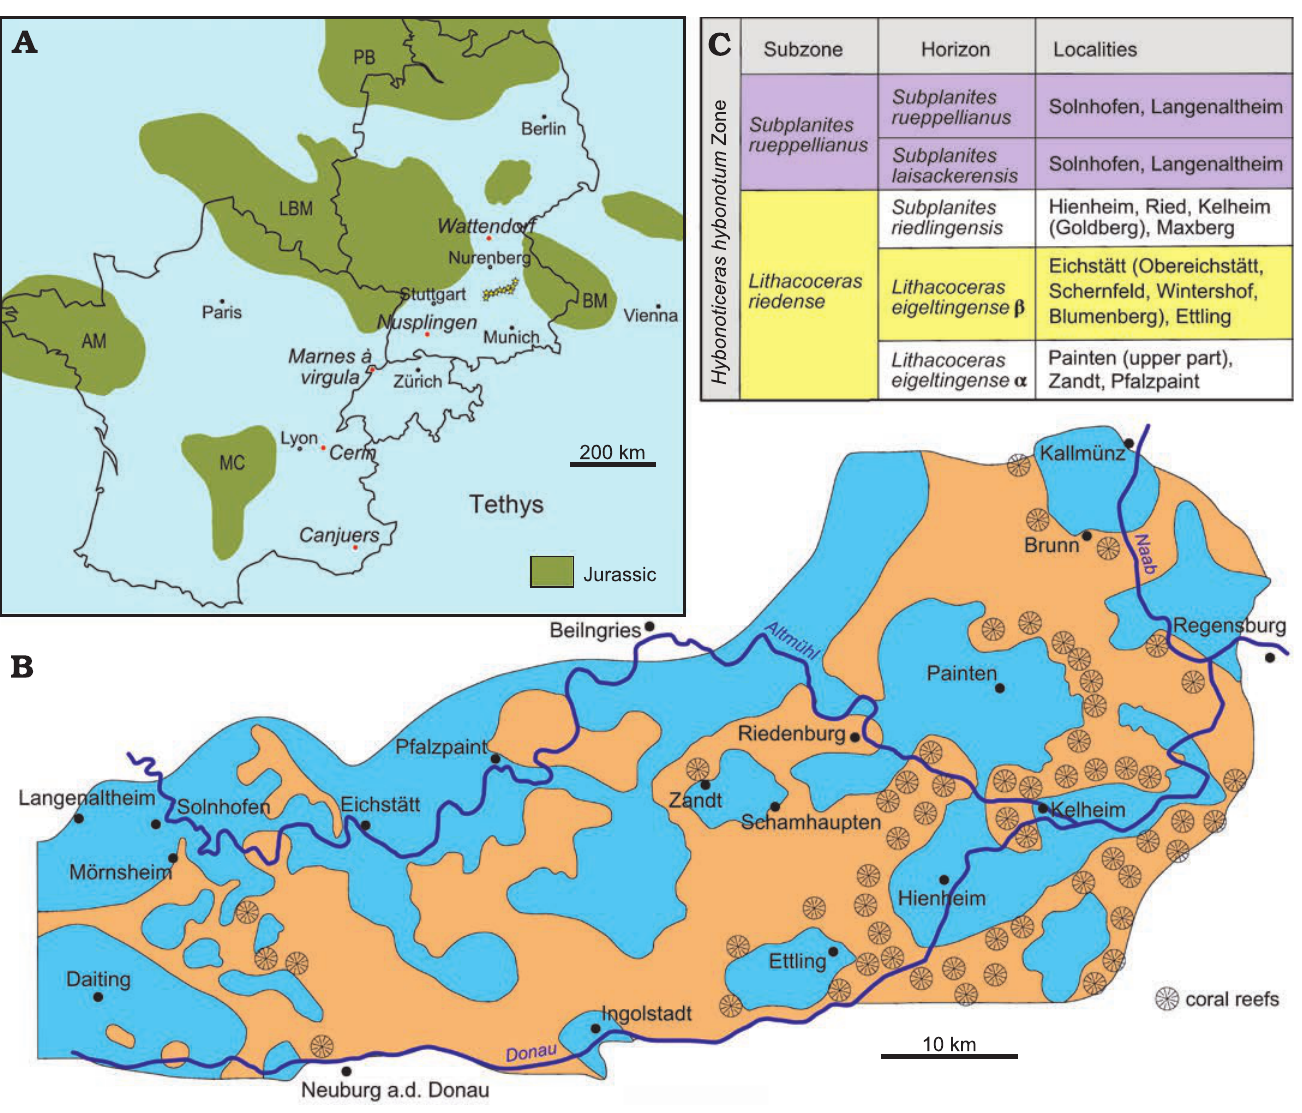
Fig. 1. Geographic and stratigraphic setting. A . Palaeogeographic reconstruction showing the location of the main Upper Jurassic Plattenkalk Lagerstätten in central Europe. The Solnhofen Archipelago is represented with several stars, other Lagerstätten are indicated with dots and italicised names. Abbreviations: AM, Armorican Massif; Bm, Bohemian Massif; LBM, London-Brabant Massif; MC, Massif Central High; PB, Pompeckjsche Block. Redrawn from Viohl (2015: fig. 85). B . Palaeogeographic reconstruction of the Solnhofen Archipelago. Orange areas represent sponge/microbial reefs and blue areas represent the basinal facies. Redrawn from Kölbl-Ebert and Cooper (2019: fig. 2). C . Biostratigraphy with ammonite stratigraphic succession of the Lithacoceras riedense and Subplanites rueppellianus subzones of the Hybonoticeras hybonotum Zone (lower Tithonian, Upper Jurassic). Redrawn from Tischlinger and Schweigert (2020: fig.